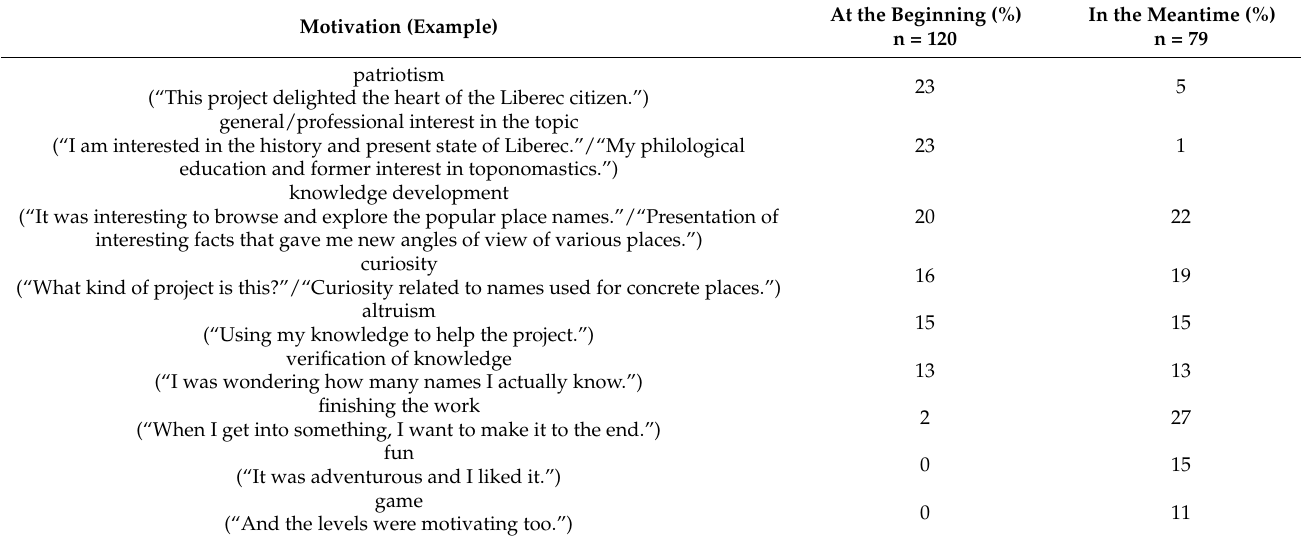
Table 1. Basic categories of motivation and their frequency in the second phase of the Living Names project. Some respondents participated for more than one reason, thus their answers are counted in several categories. Motivation in the meantime is calculated from respondents who processed the entire database (66% of respondents).